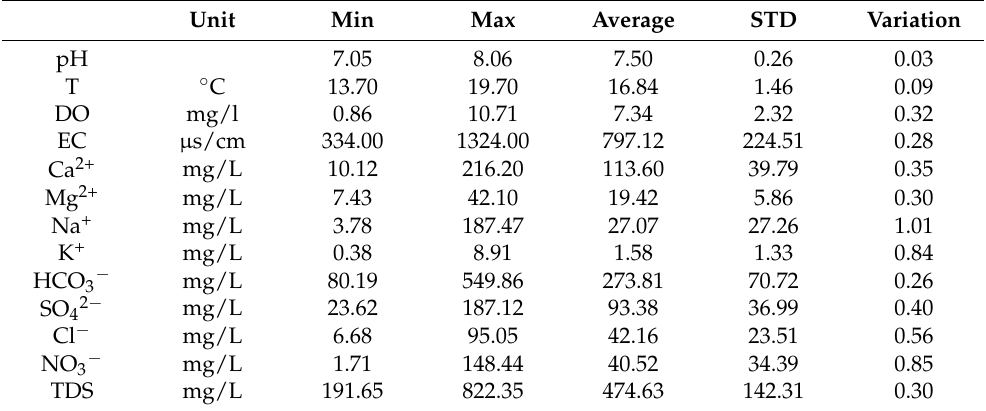
Table 1. Summary of Chemical data and in situ physico-chemical parameters of the collected karst water samples. Concentration in mg/L, except pH and temperature